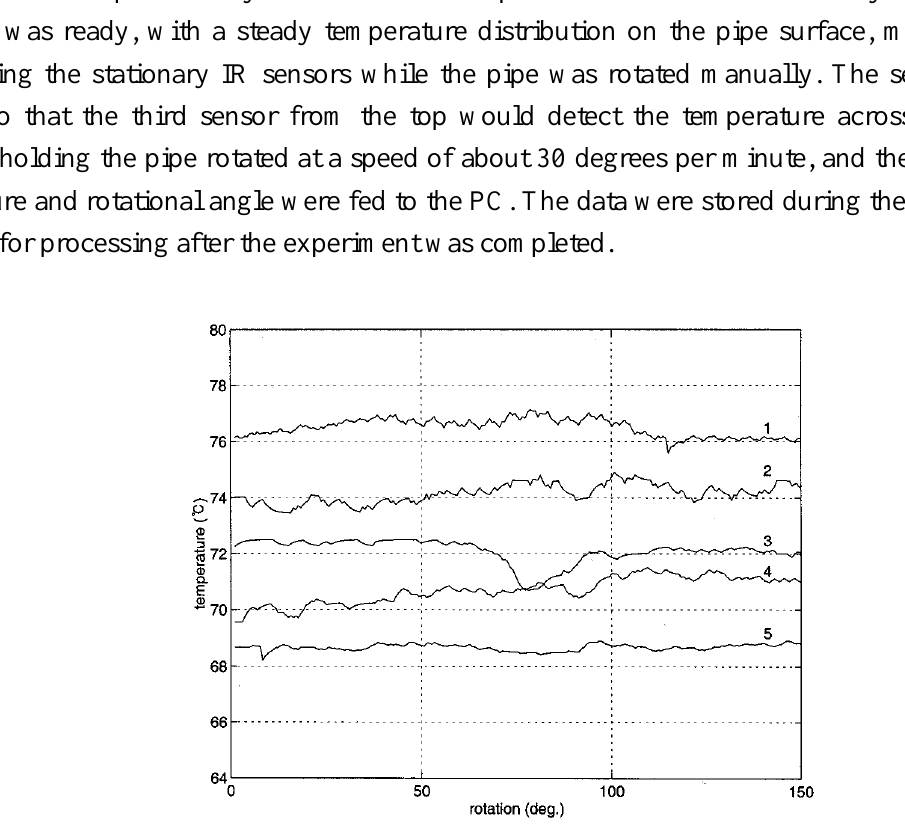
Figure 4. Variations of measured temperatures in the pipe